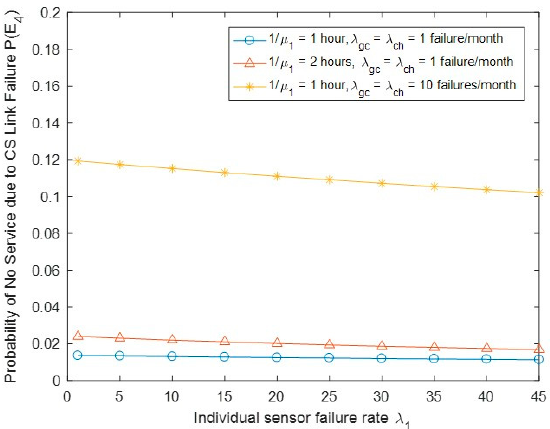
Figure 9. Probability of no service due to CS link failure P ( E 4 ) vs. biosensor failure rate λ 1 .